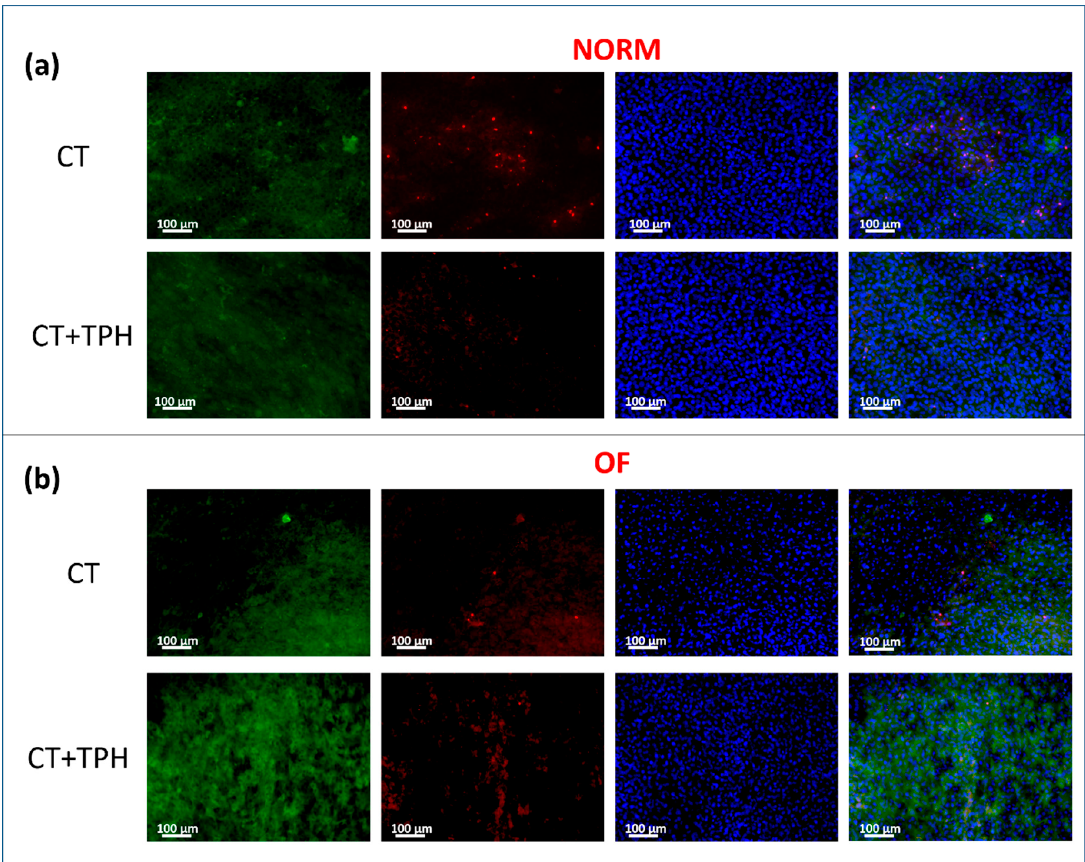
Figure 5. Fluorescence images performed using blue probe for cell nucleus (DAPI), Red probe for dead cells (PI) and green probe for osteocalcin (Hoechst33342). The images were performed at 20 × magnifications; ( a ) reports the results of the samples cultured with the normal medium and ( b ) shows the results of the medium cultured with the osteoinductive factors.